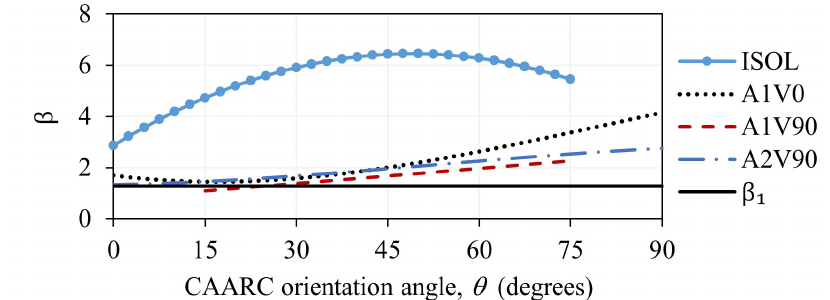
Figure 13. Reliability index β for acceleration, y-direction – limit criterion of 8.4 cm/s 2 .